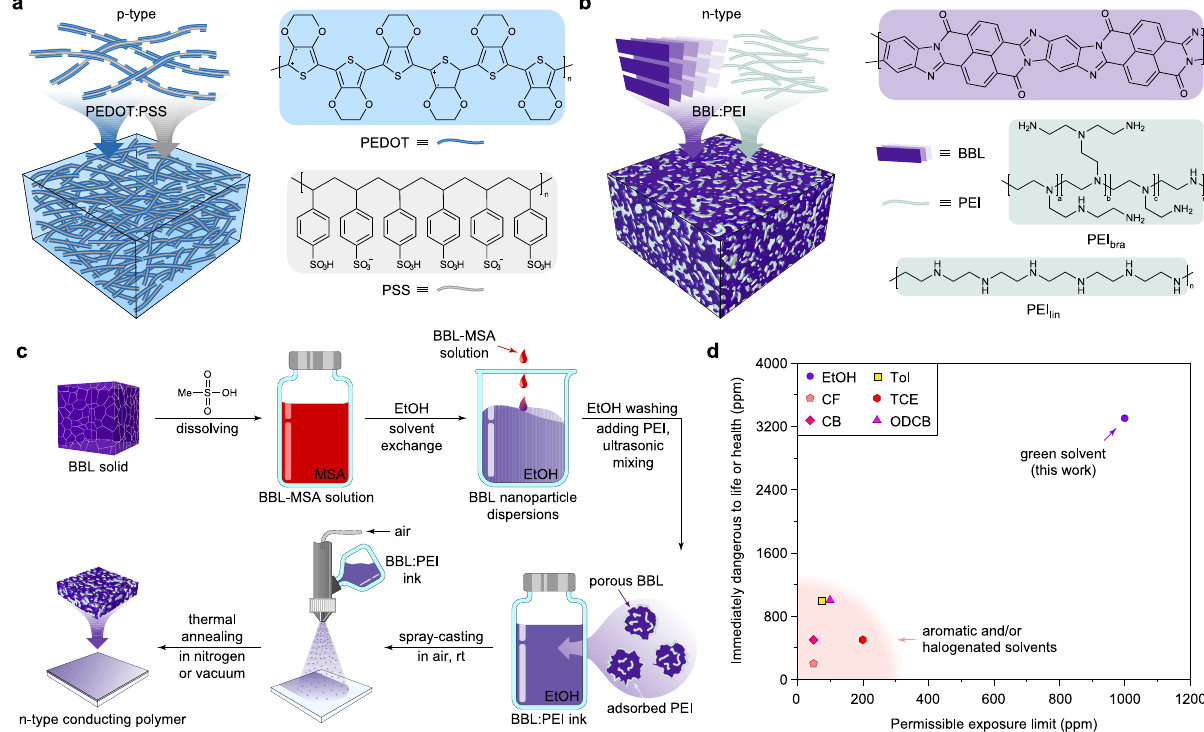
Fig. 1 Material processing. a Schematics of the fi lm structure and chemical structure of p -type PEDOT:PSS. b Schematics of the fi lm structure and chemical structures of BBL, PEI lin , and PEI bra polymers. c Processing steps to obtain the BBL:PEI ink and its deposition through spray-coating. BBL powder is dissolved in MSA, followed by dispersion in ethanol through a solvent-exchange method, which results in the formation of BBL nanoparticles, and fi nally mixing with PEI to form the fi nal BBL:PEI ink; BBL:PEI ink can be spray-coated in air, followed by thermal annealing, to form the highly conducting n -type fi lm. d Health exposure limits of the solvent used for the BBL:PEI ink and comparison with other solvents typically used to process n -type conducting polymers (Tol, toluene; CF, chloroform; TCE, trichloroethylene; CB, chlorobenzene; and ODCB, 1,2-dichlorobenzene). Data from the US National Institute for Occupational Safety and Health (NIOSH, see Supplementary Table